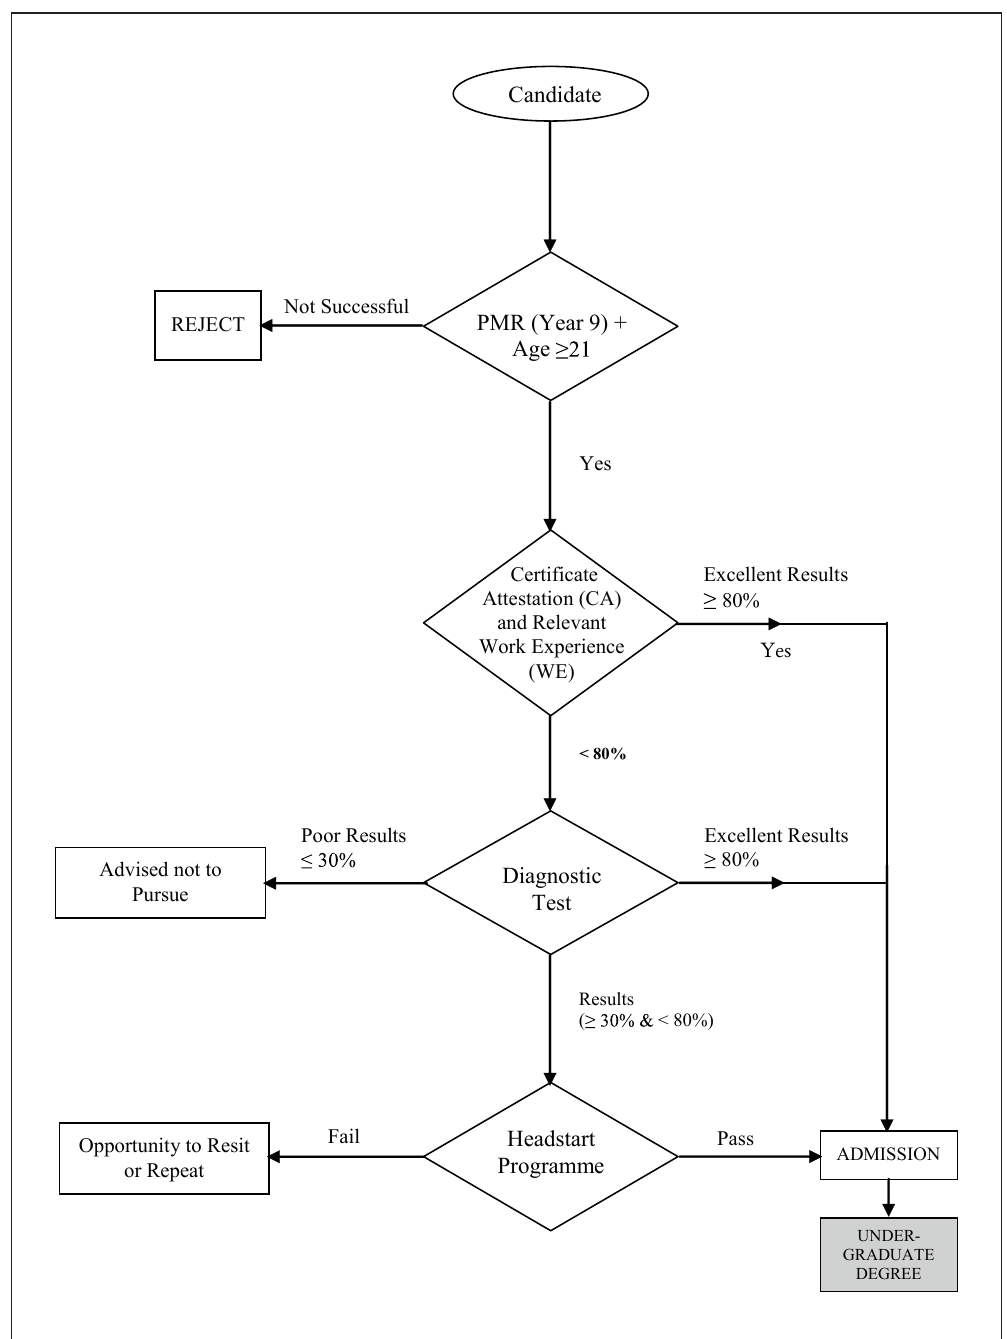
Figure 1 WOU RPEL process